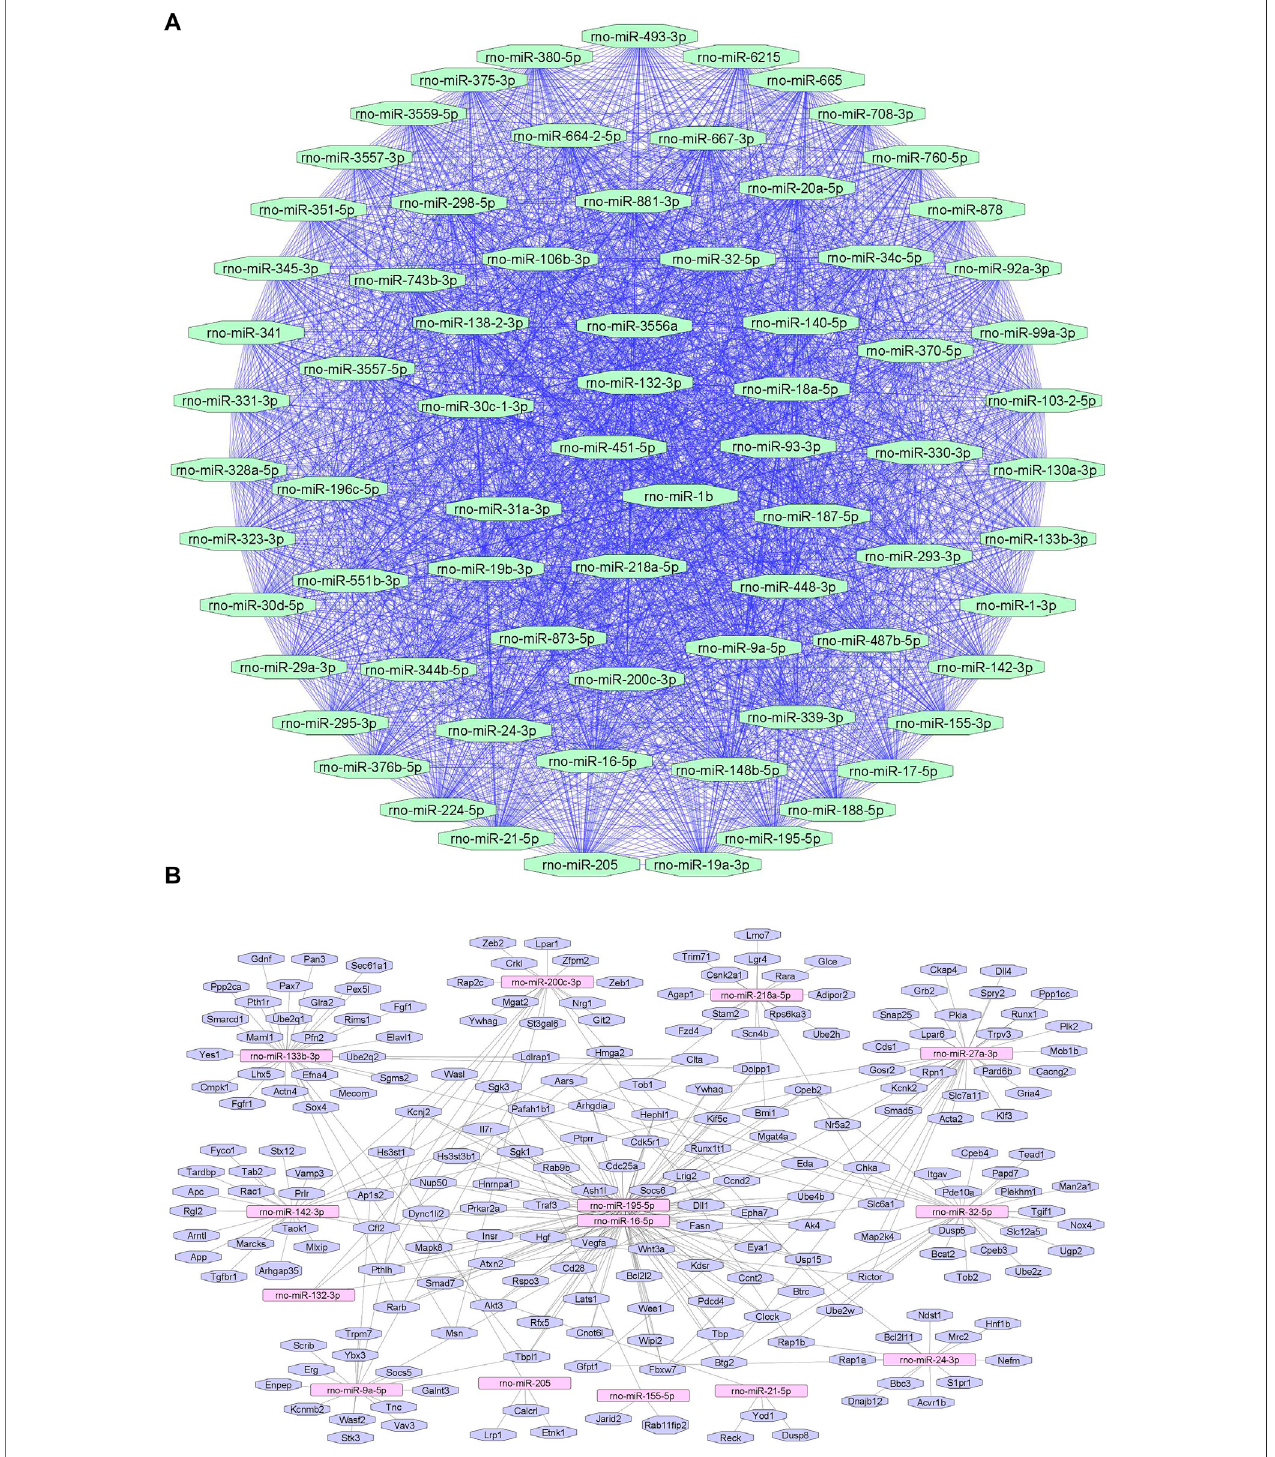
FIGURE 3 | Upregulated rat microRNA networks in neuropathic pain: (A) Rat microRNA – microRNA network: Rat miRNA-miRNA interaction network with 73 nodes and 2,628 edges. The networks were constructed using Cytoscape 3.8.2. (B) Rat microRNA – gene target network: Architecture of networks of upregulated miRNAs in rat implicated in neuropathic pain showing interaction network of functionally enriched miRNAs with their targets with 205 nodes and 280 edges. The networks were constructed using Cytoscape 3.8.2. Using Mienturnet, the miRNA-target interactions were identi fi ed by TargetScan, and the functionally enriched miRNAs were generated using the KEGG database.